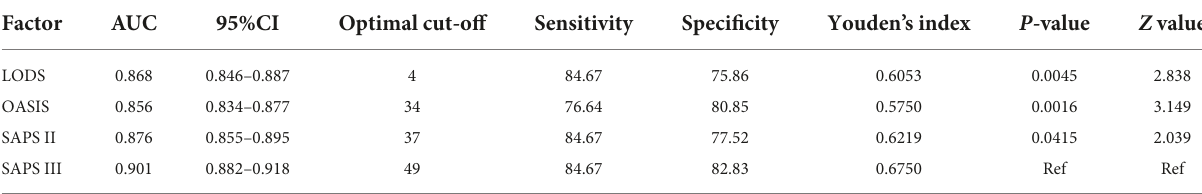
TABLE 6 Comparison of ROC curves (before PSM).